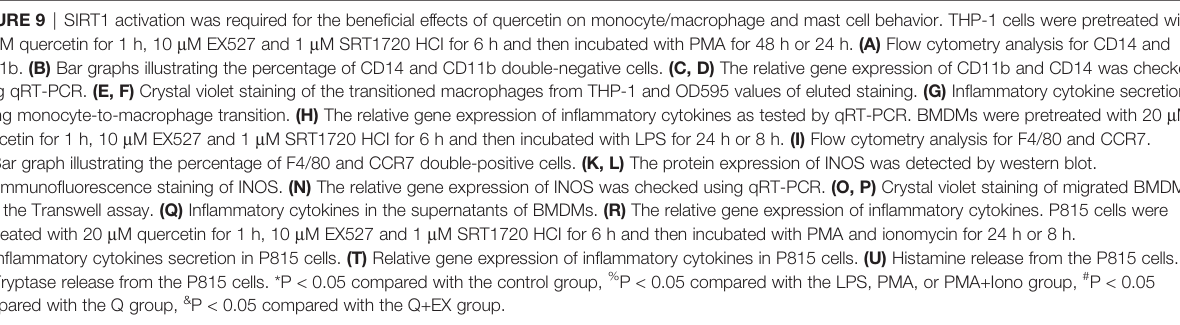
FIGURE 9 | SIRT1 activation was required for the bene fi cial effects of quercetin on monocyte/macrophage and mast cell behavior. THP-1 cells were pretreated with 20 m M quercetin for 1 h, 10 m M EX527 and 1 m M SRT1720 HCI for 6 h and then incubated with PMA for 48 h or 24 h. (A) Flow cytometry analysis for CD14 and CD11b. (B) Bar graphs illustrating the percentage of CD14 and CD11b double-negative cells. (C, D) The relative gene expression of CD11b and CD14 was checked using qRT-PCR. (E, F) Crystal violet staining of the transitioned macrophages from THP-1 and OD595 values of eluted staining. (G) In fl ammatory cytokine secretion during monocyte-to-macrophage transition. (H) The relative gene expression of in fl ammatory cytokines as tested by qRT-PCR. BMDMs were pretreated with 20 m M quercetin for 1 h, 10 m M EX527 and 1 m M SRT1720 HCI for 6 h and then incubated with LPS for 24 h or 8 h. (I) Flow cytometry analysis for F4/80 and CCR7. (J) Bar graph illustrating the percentage of F4/80 and CCR7 double-positive cells. (K, L) The protein expression of INOS was detected by western blot. (M) Immuno fl uorescence staining of INOS. (N) The relative gene expression of INOS was checked using qRT-PCR. (O, P) Crystal violet staining of migrated BMDMs after the Transwell assay. (Q) In fl ammatory cytokines in the supernatants of BMDMs. (R) The relative gene expression of in fl ammatory cytokines. P815 cells were pretreated with 20 m M quercetin for 1 h, 10 m M EX527 and 1 m M SRT1720 HCI for 6 h and then incubated with PMA and ionomycin for 24 h or 8 h. (S) In fl ammatory cytokines secretion in P815 cells. (T) Relative gene expression of in fl ammatory cytokines in P815 cells. (U) Histamine release from the P815 cells. (V) Tryptase release from the P815 cells. *P < 0.05 compared with the control group, % P < 0.05 compared with the LPS, PMA, or PMA+Iono group, # P < 0.05 compared with the Q group, & P < 0.05 compared with the